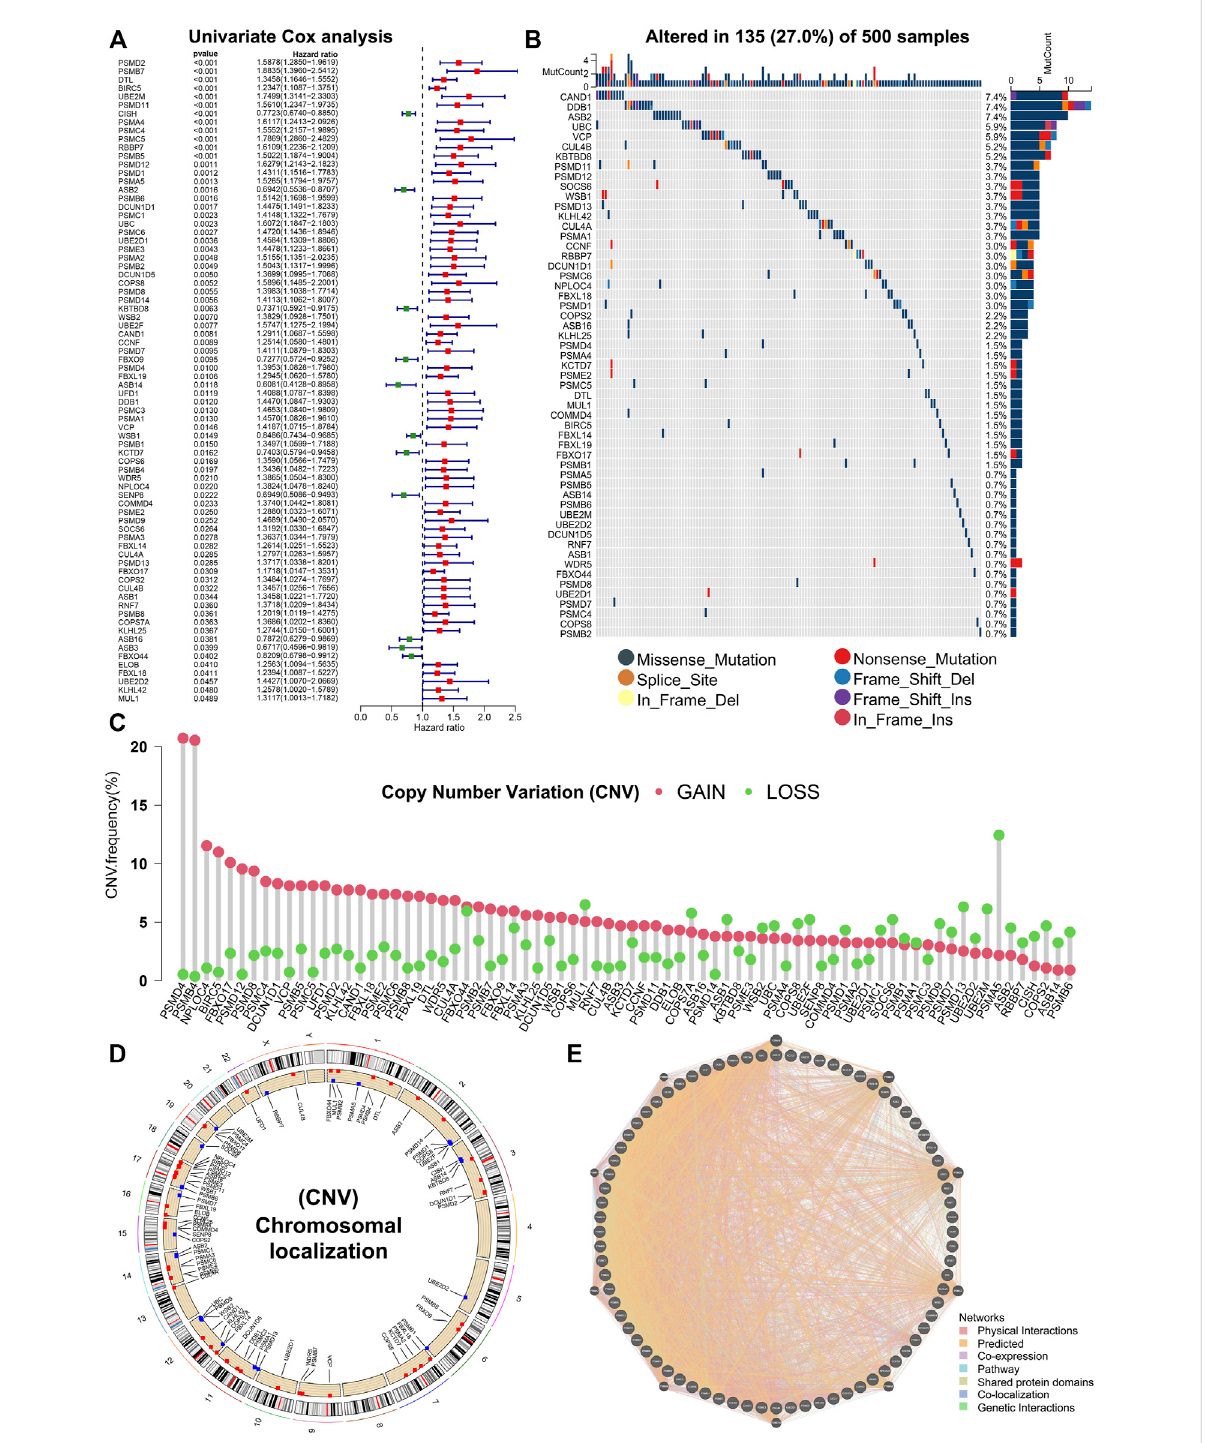
FIGURE 2 Genetic variants in 76 prognostic genes. (A) Univariate Cox analysis identifying 76 prognostic genes. (B) Mutation landscape of prognostic genes. (C,D) CNV in prognostic genes. (E) PPI network of prognostic genes.